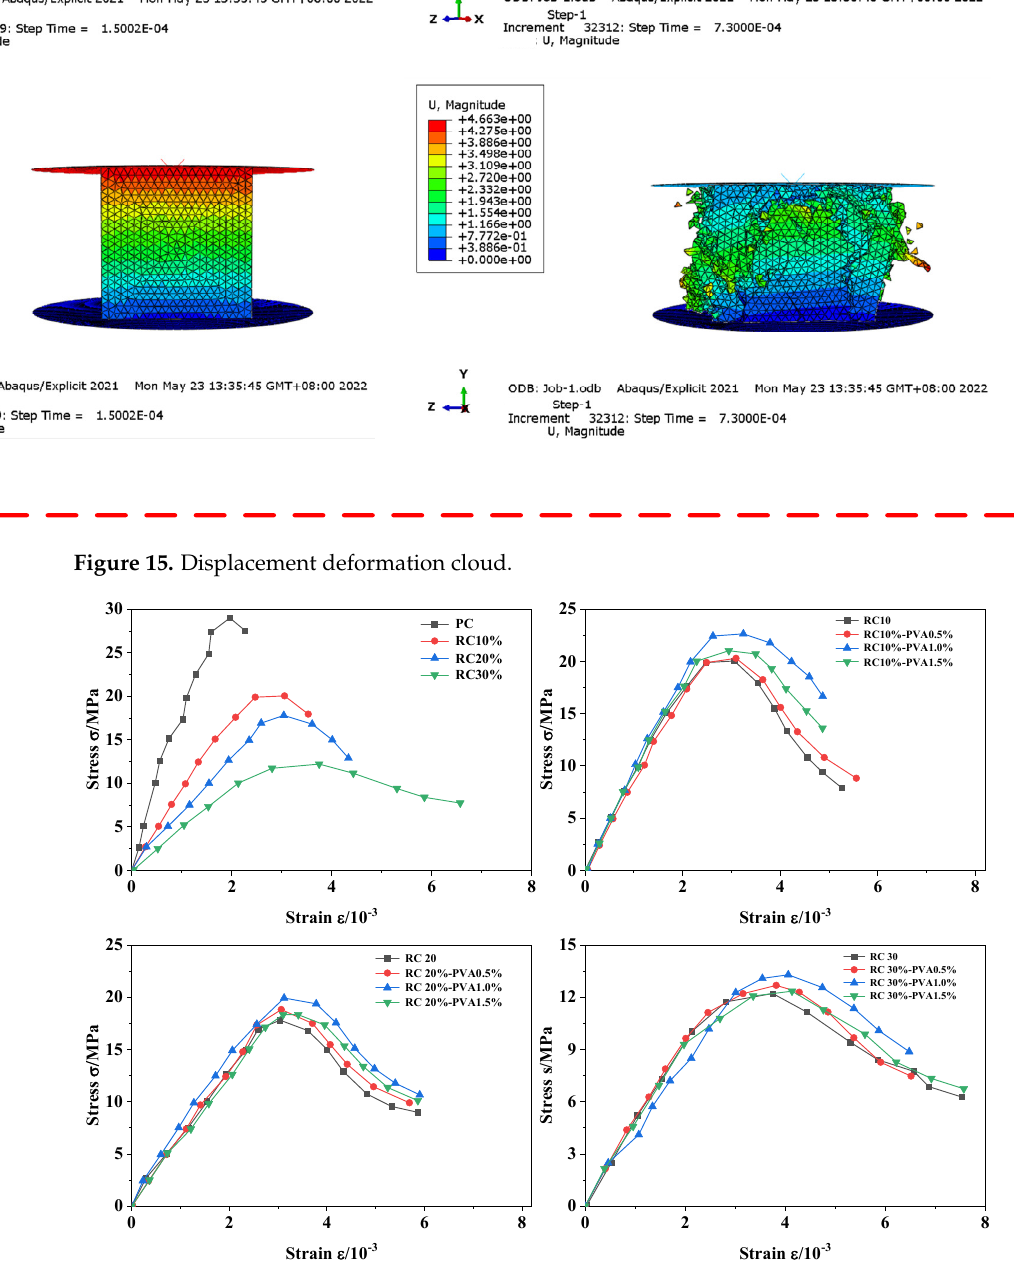
Figure 16. Finite element simulation of stress–strain curve.